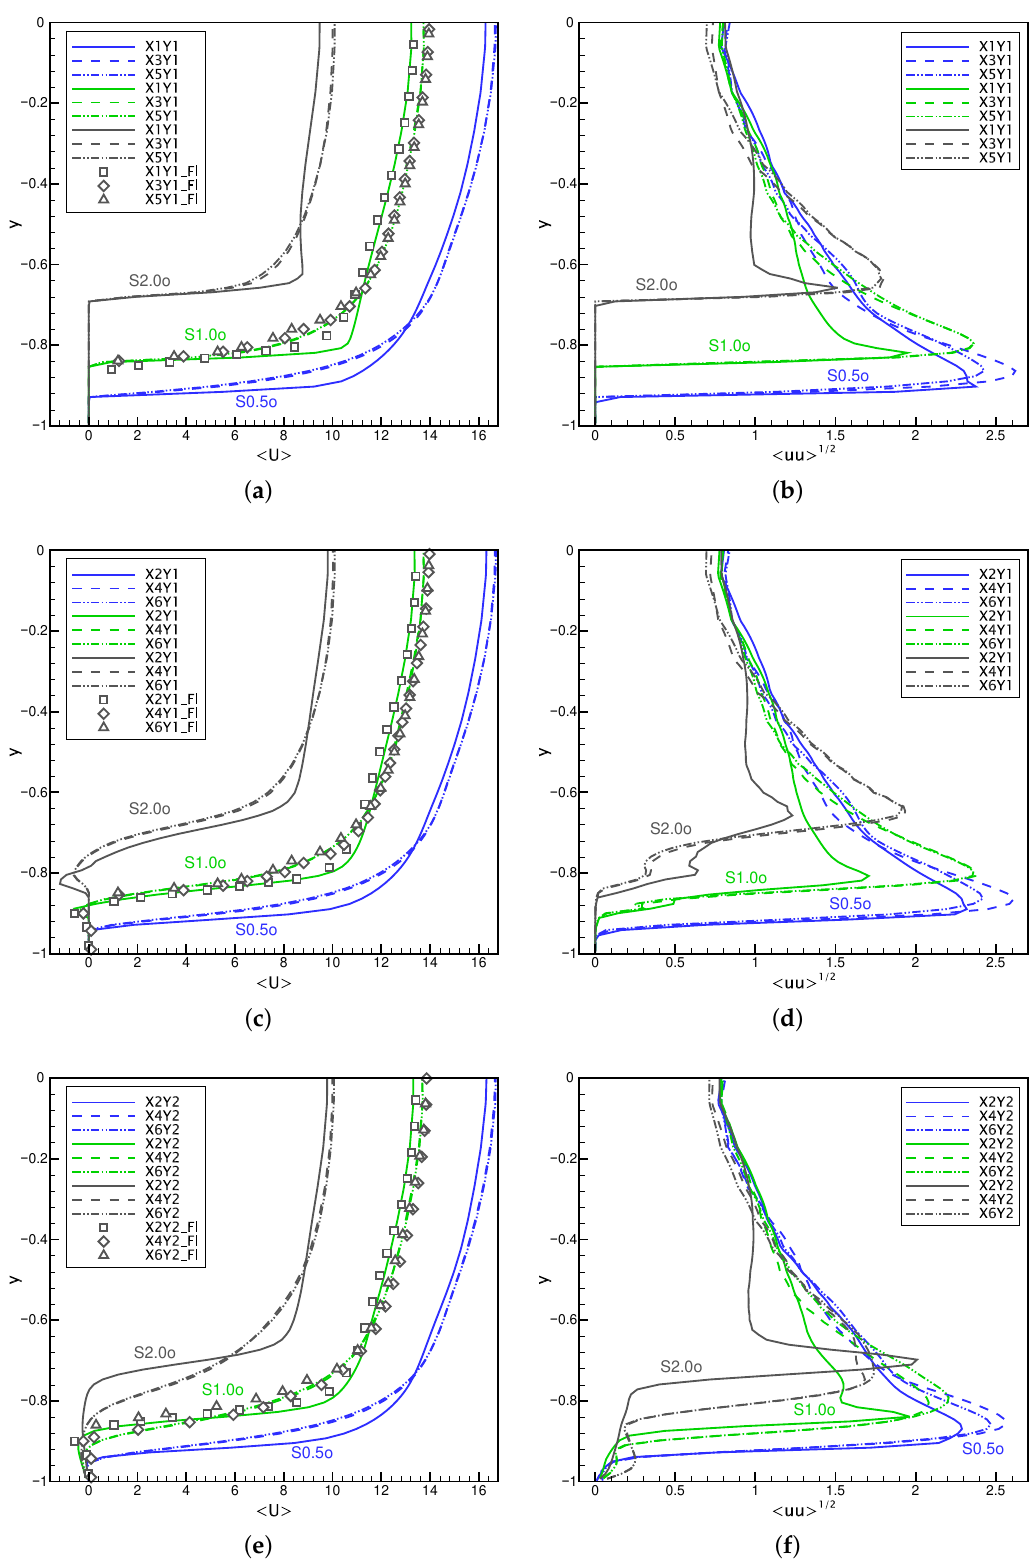
Figure 9. Profiles of the time-averaged streamwise velocity ( a , c , e ) and its fluctuations ( b , d , f ) along the channel height at the selected control points X and Y defined in Figure 3a. The results for the configurations S0.5o, S1.0o, and